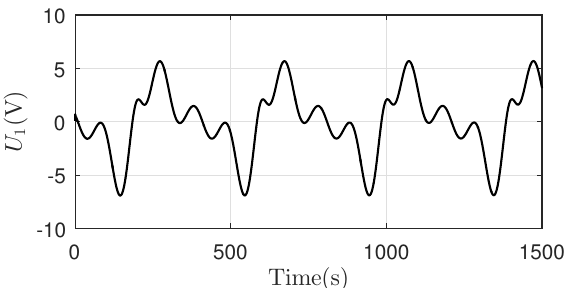
Figure 14. Control input U 1 in submerging motion with a constant velocity and variable pitch angle command.